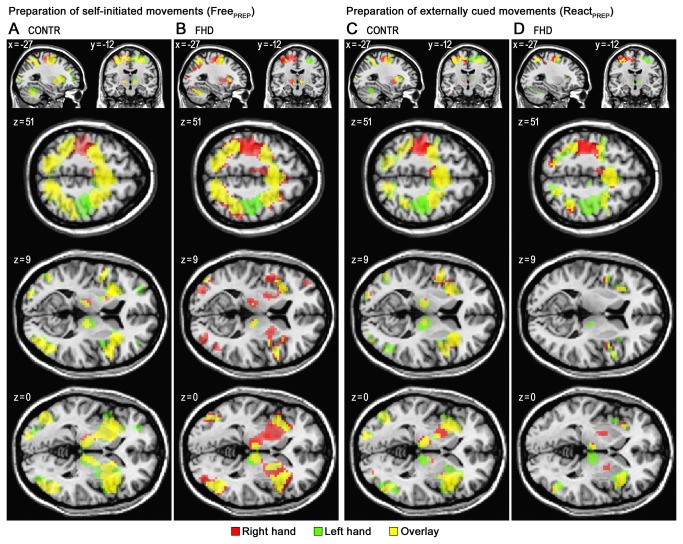
Within-group Activity during Preparation of Movements.Within-group activity during preparation of movements in healthy control subjects (CONTR; A and C) and focal hand dystonia patients (FHD; B and D). Activation during motor preparation (PREP) of self-initiated (Free; A and B) and externally cued (React; C and D) conditions. Voxels surpassing a height threshold of p < 0.001 (FDR-corrected) and an extent threshold (cluster size) of k=10 are superimposed on the MNI-T1-template of SPM5, and color coded for right hand (red), left hand (green) and common activations (overlay; yellow). Coordinates shown (x, y, z) are in MNI-space.